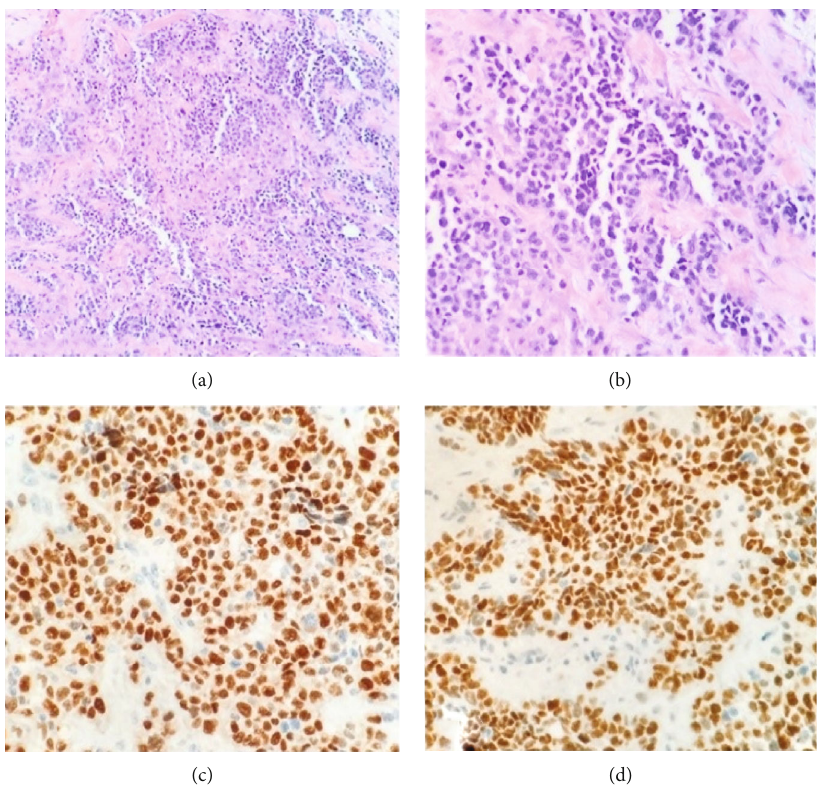
Figure 2: Histological and IHC analysis of alveolar RMS. Small cells with scarce cytoplasm and rounded and hyperchromatic nucleus grouping into nests with pseudoalveolar spaces under optical microscopy at 20x (a) and 40x (b). Strong and di ff use nuclear marking (higher than 50%) of myogeny (c) and MyoD1 (d) in neoplastic cells that corroborated initial